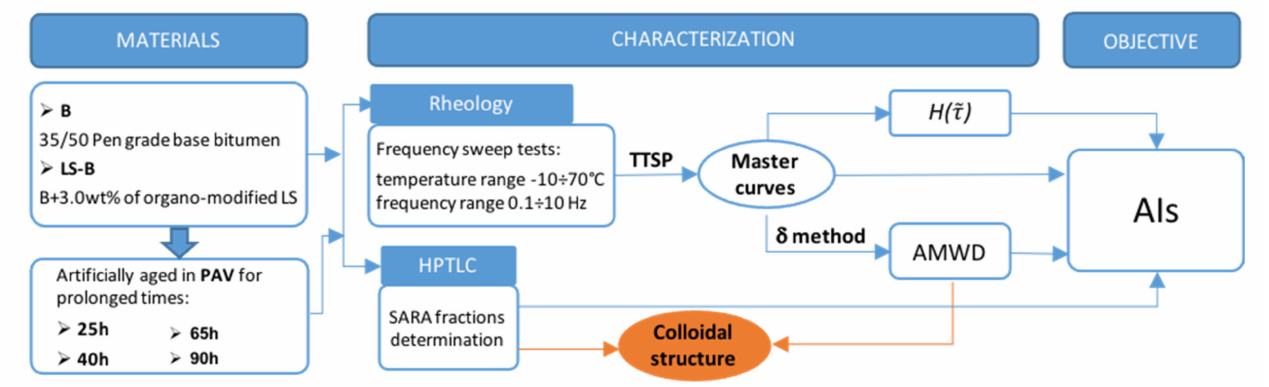
Scheme 1. Experimental design.